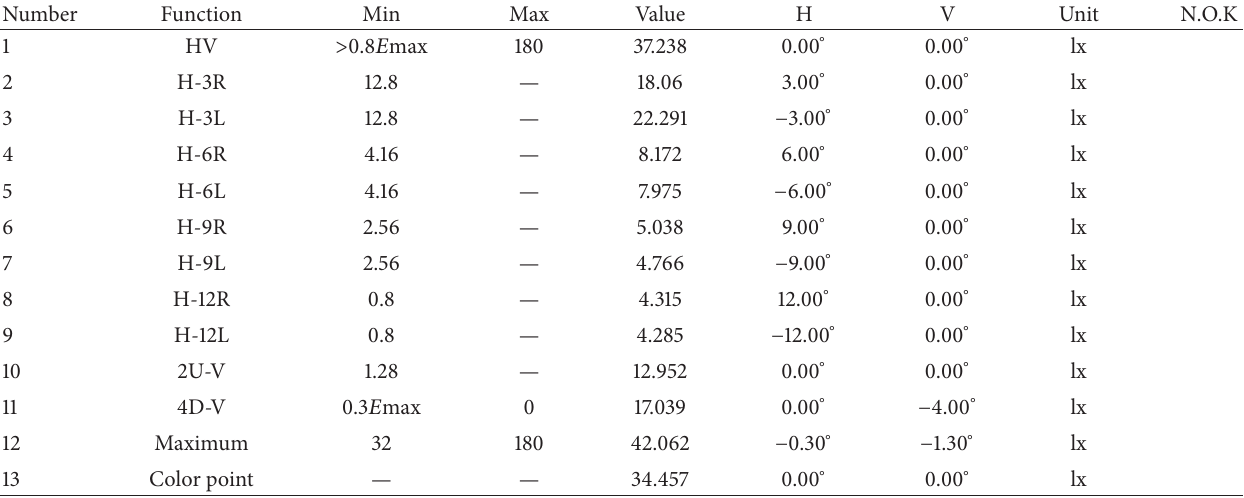
Table 1: The measured